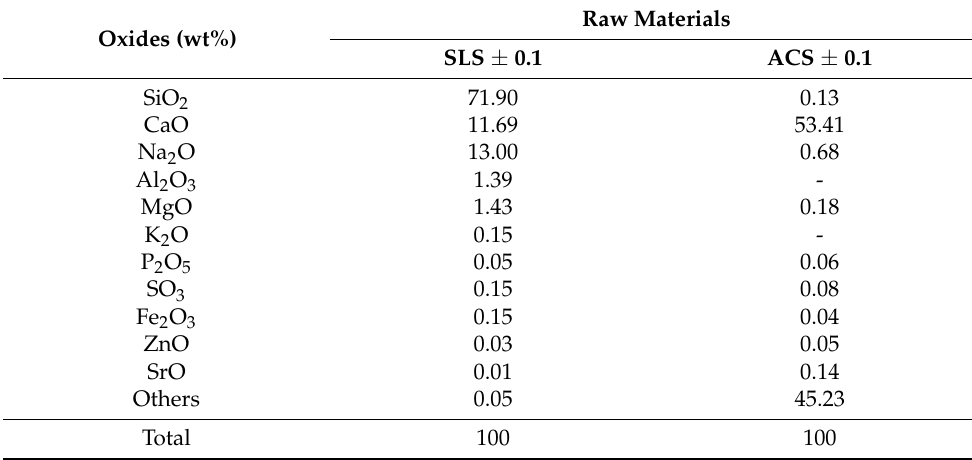
Table 2. Chemical composition of SLS glass and